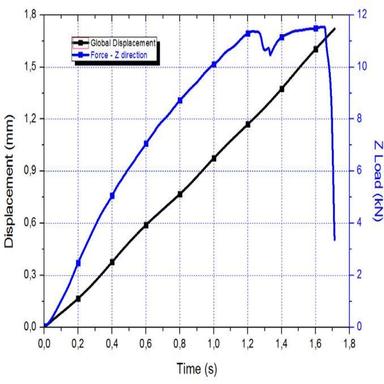
Typical raw data on high speed hydraulic machine.